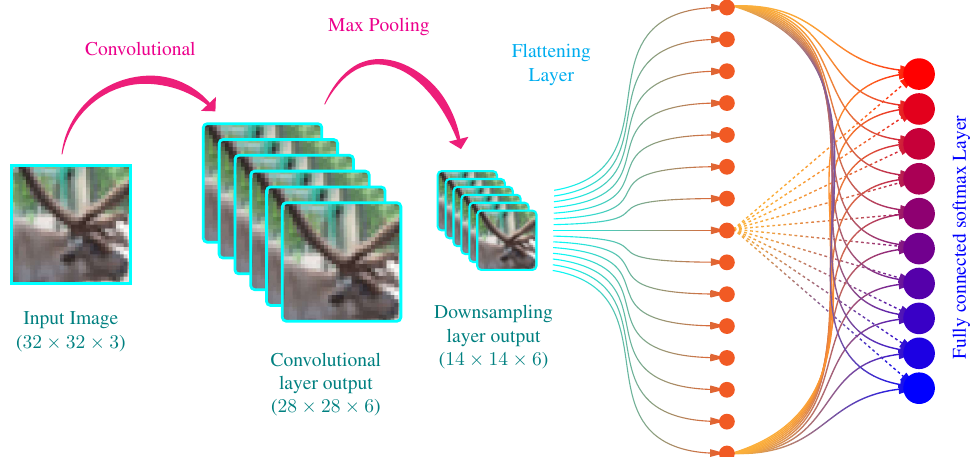
Figure 2. A simple structure of CNN for an image classification task. The network consists of one convolutional layer, one downsampling layer, and a fully connected layer followed by the output layer. The network output the probabilities that the image contains particular